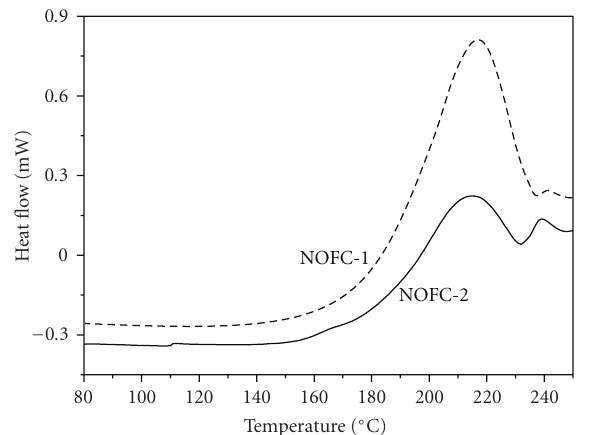
Figure 5: DSC scan of ERL-4221 with 1.0wt% ferrocenium salts (heating rate = 10 ◦ C/min static